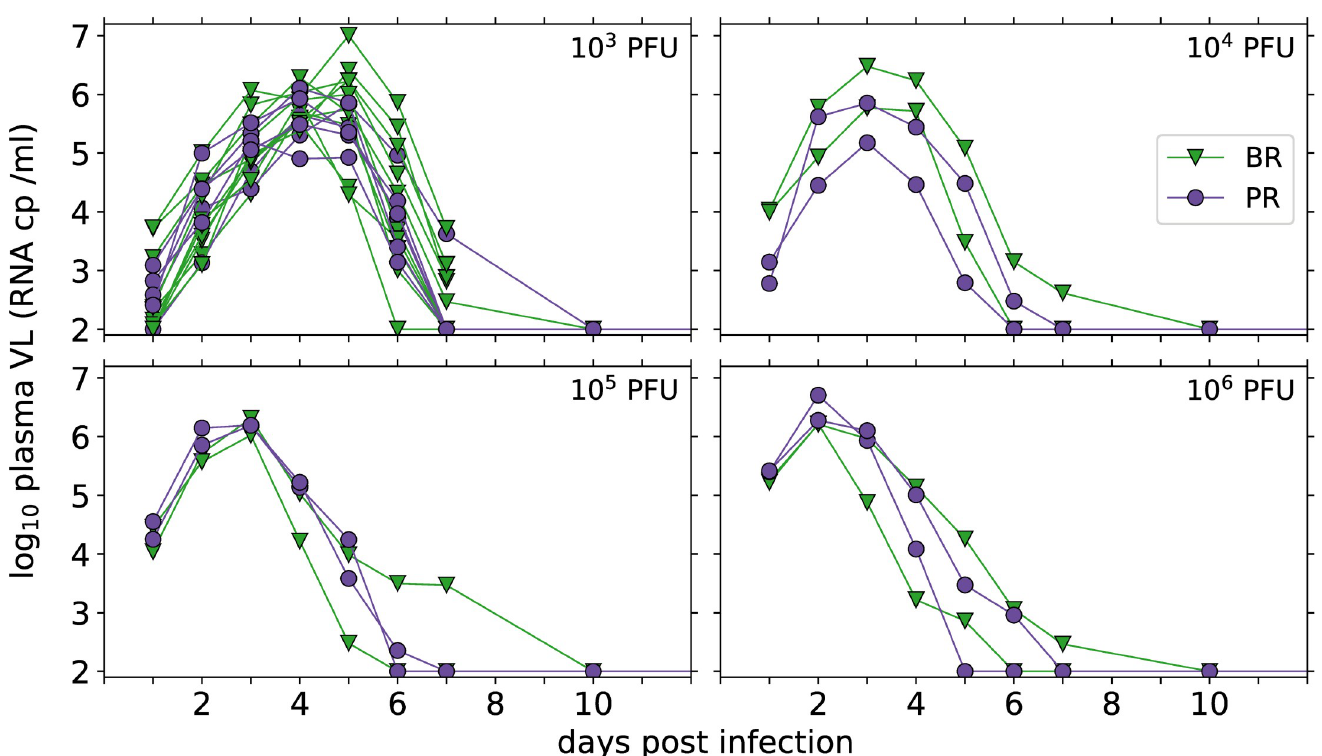
Fig 1. Plasma viral load measurements, in copies (cp) per ml, in rhesus macaques inoculated subcutaneously with the indicated dose of Brazilian (BR, green triangles) or Puerto Rican (PR, purple circles) ZIKV. The limit of detection of the experimental assay is 100 RNA cp /ml, and when ZIKV was undetectable in a sample it is shown here at the limit of detection for illustrative